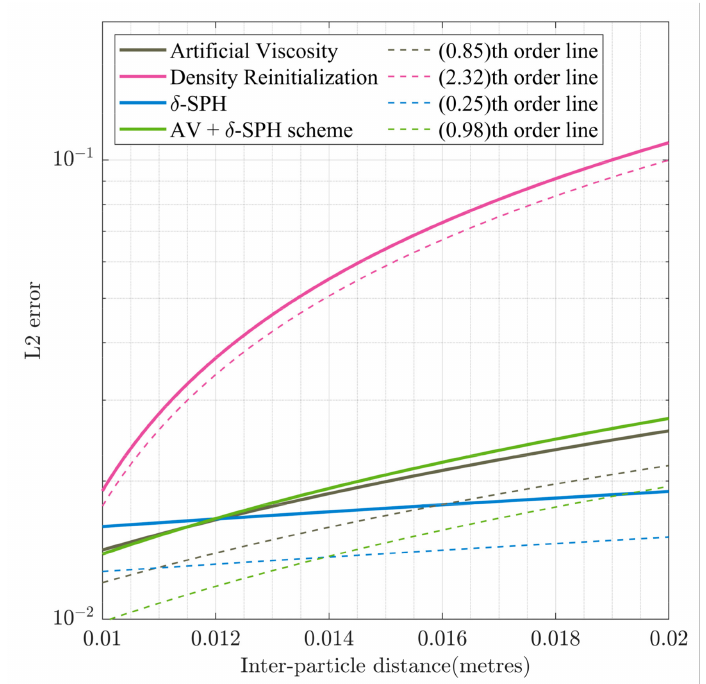
Figure 15. The computed L2 error for the grid study interpolated over the range of particle resolution shown for the different numerical dissipation schemes used for the wave tank experiment using Wendland C6 kernel. Different order lines are provided to aid in the interpretation of the convergence rates for the dissipation